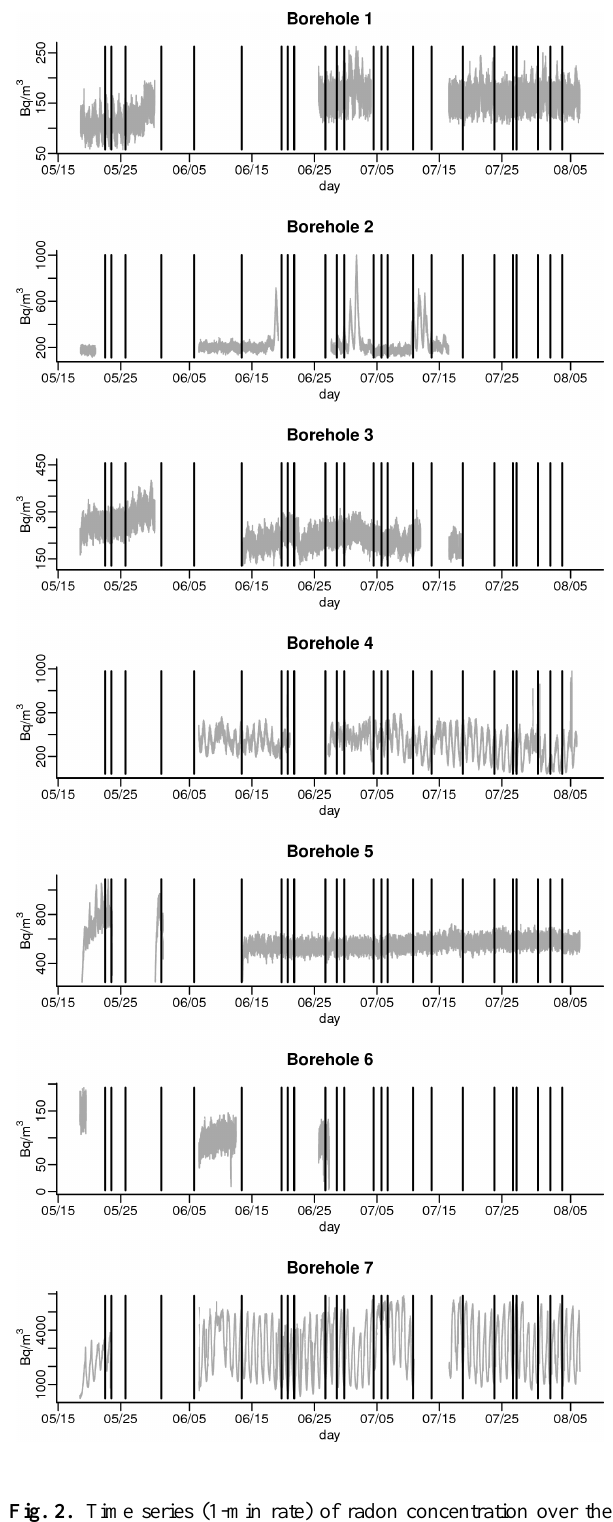
Fig. 2. Time series (1-min rate) of radon concentration over the complete data acquisition period (16 May to 6 August). The vertical solid lines indicate the time of explosions in the